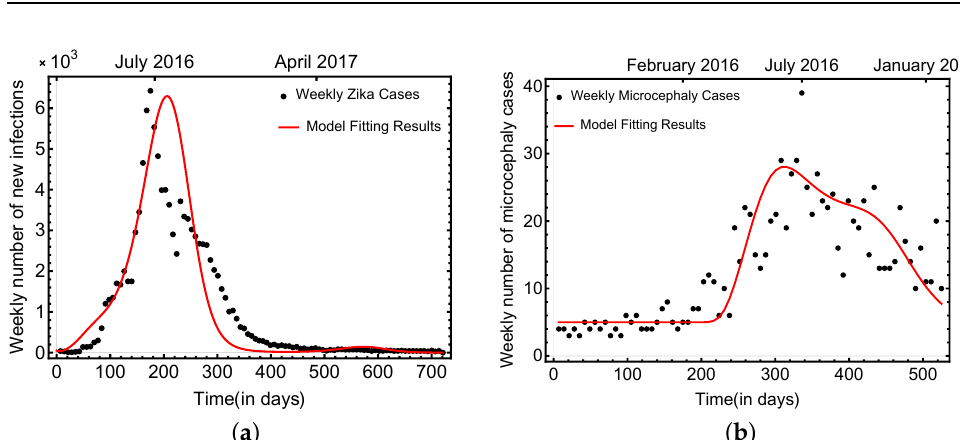
Figure 4. The model (1) fits Colombian data between 2015 and 2017, with parameter values shown in Table 2. ( a ) Number of symptomatically infected. ( b ) Number of microcephaly